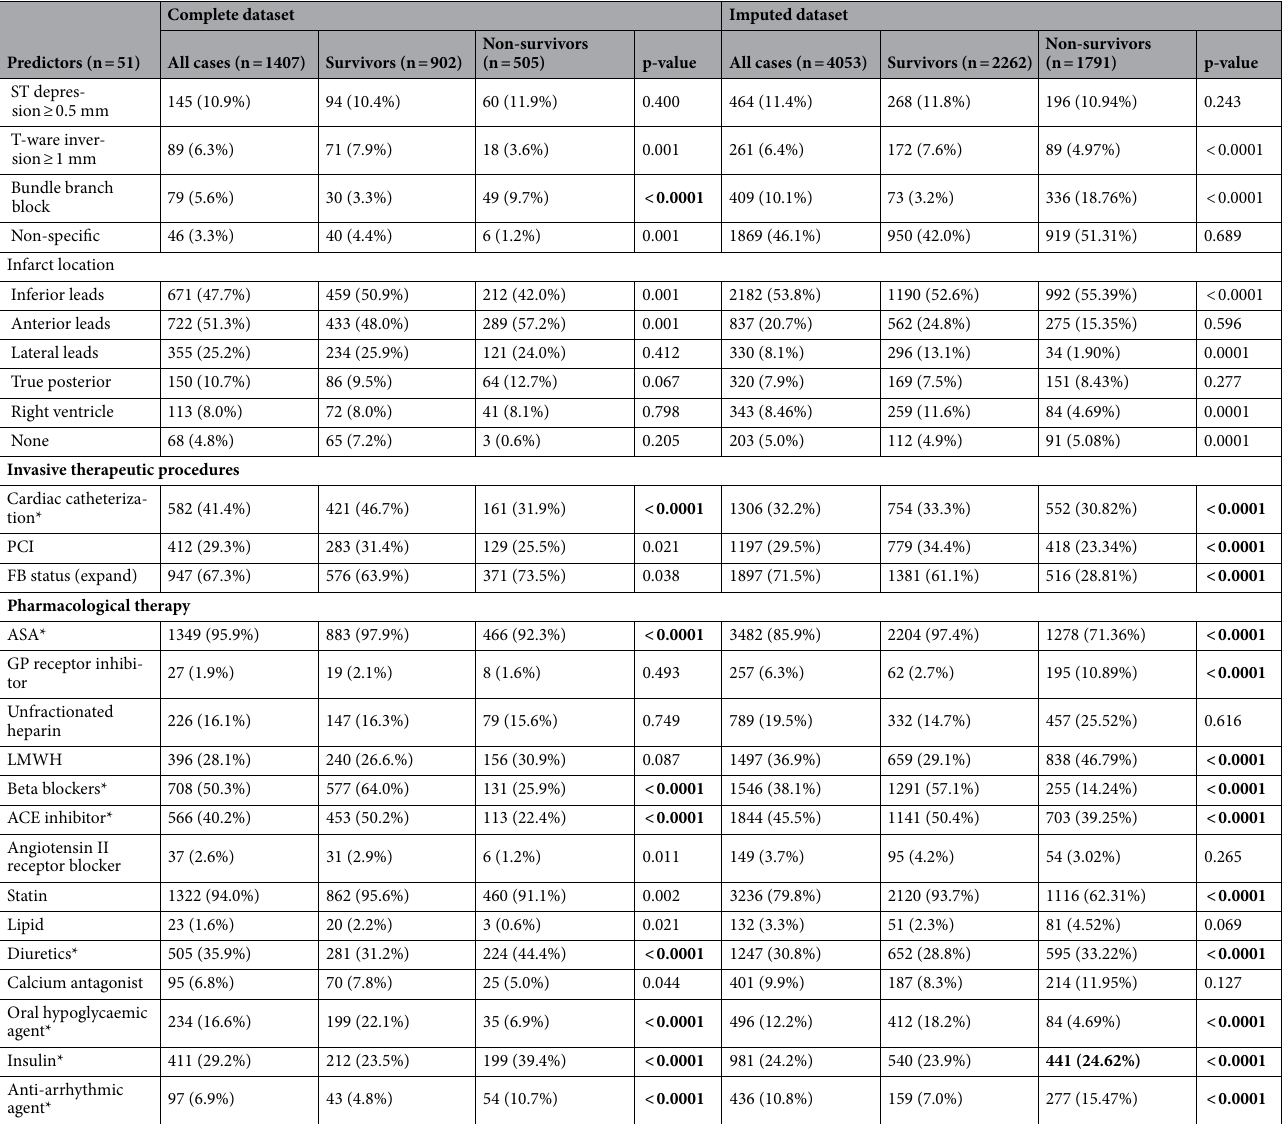
Table 2. Summary statistic of complete and imputed dataset. CAD coronary artery disease, HDL high-density lipoprotein, LDL low-density lipoprotein, ECG electrocardiogram, PCI percutaneous coronary